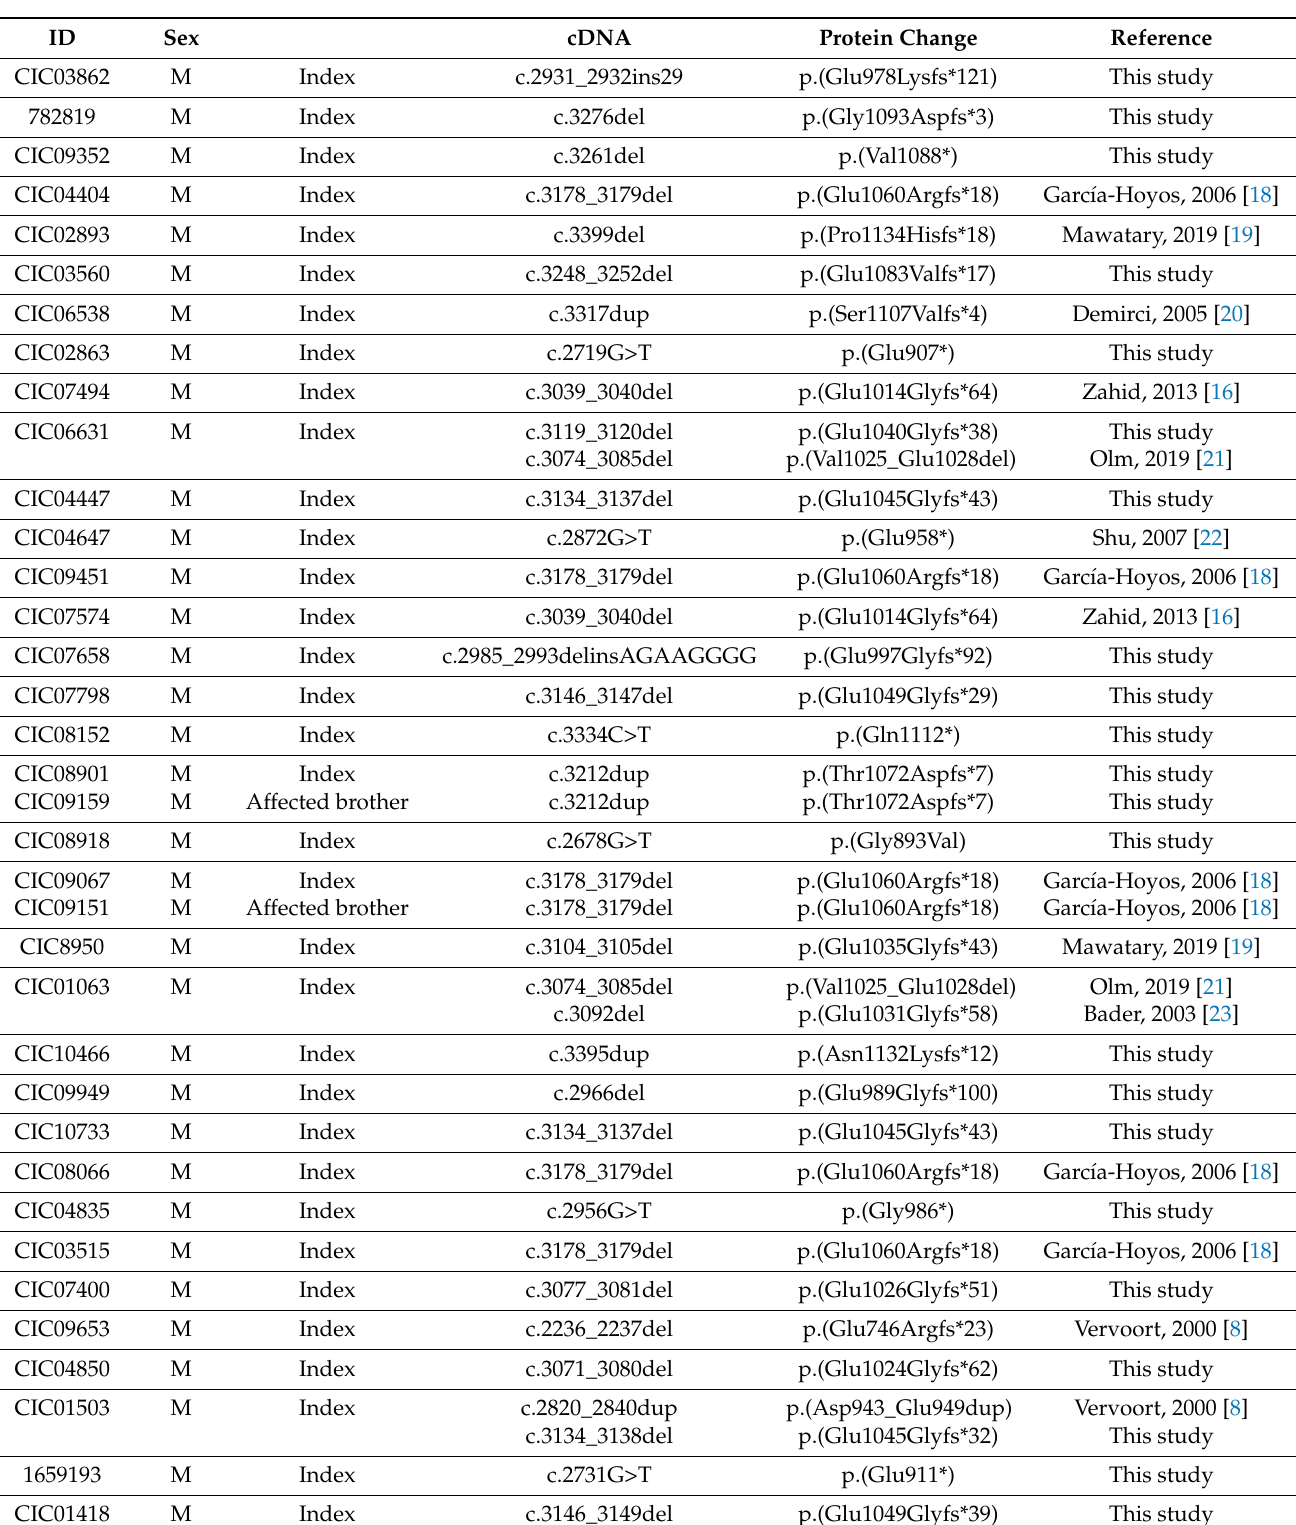
Table 1. The distinct variants in index patients with RPGR-related cone-rod dystrophy and cosegre- gation analysis. Nucleotide positions correspond to NM_001034853.2 for RPGR ORF15